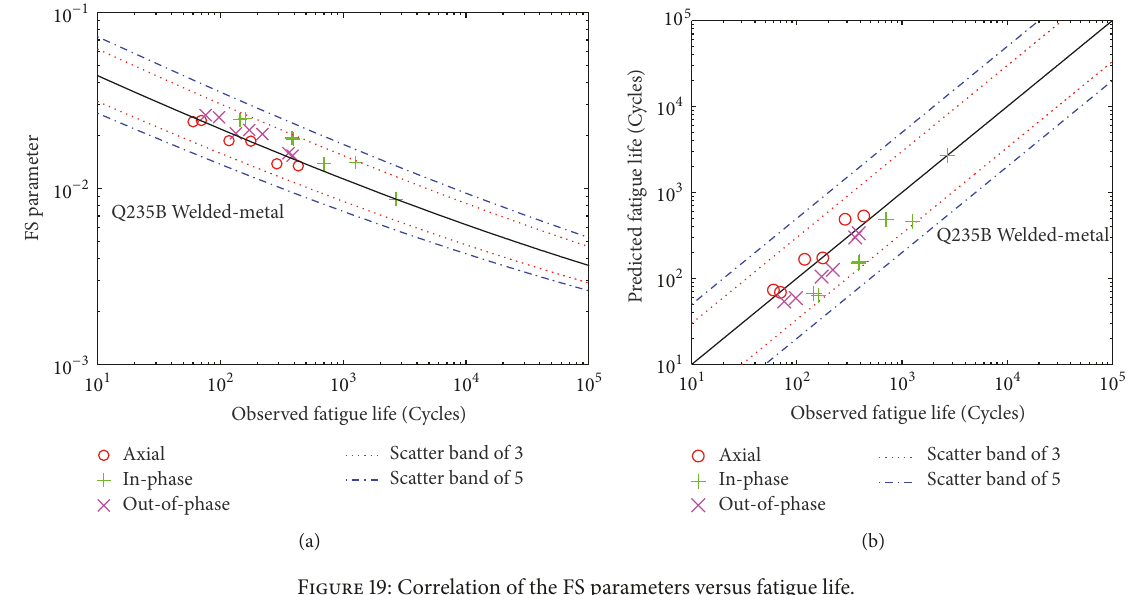
Figure 19: Correlation of the FS parameters versus fatigue life.